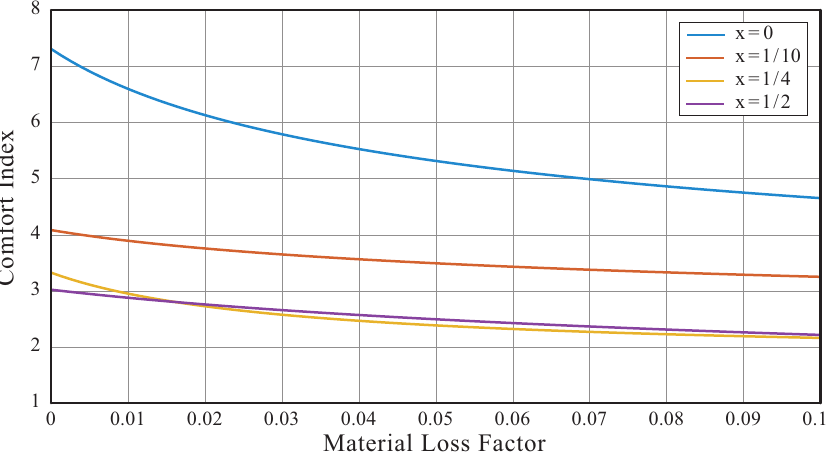
Figure 11. Comfort index at four locations on the beam versus the material loss factor ( η ).